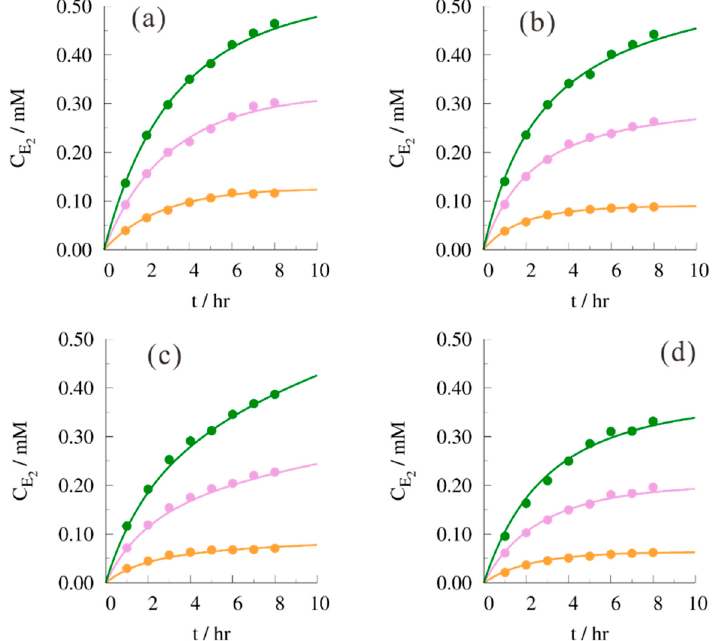
Figure 3. Concentration of byproduct E 2 as a function of reaction time. T = 80 °C and solvent = ( a ) methanol; ( b ) ethanol; ( c ) n-propanol; ( d ) n-butanol; ( – , (cid:8) ) ( B / H ) 0 = 2 mol mol − 1 , ( – , (cid:8) ) ( B / H ) 0 =